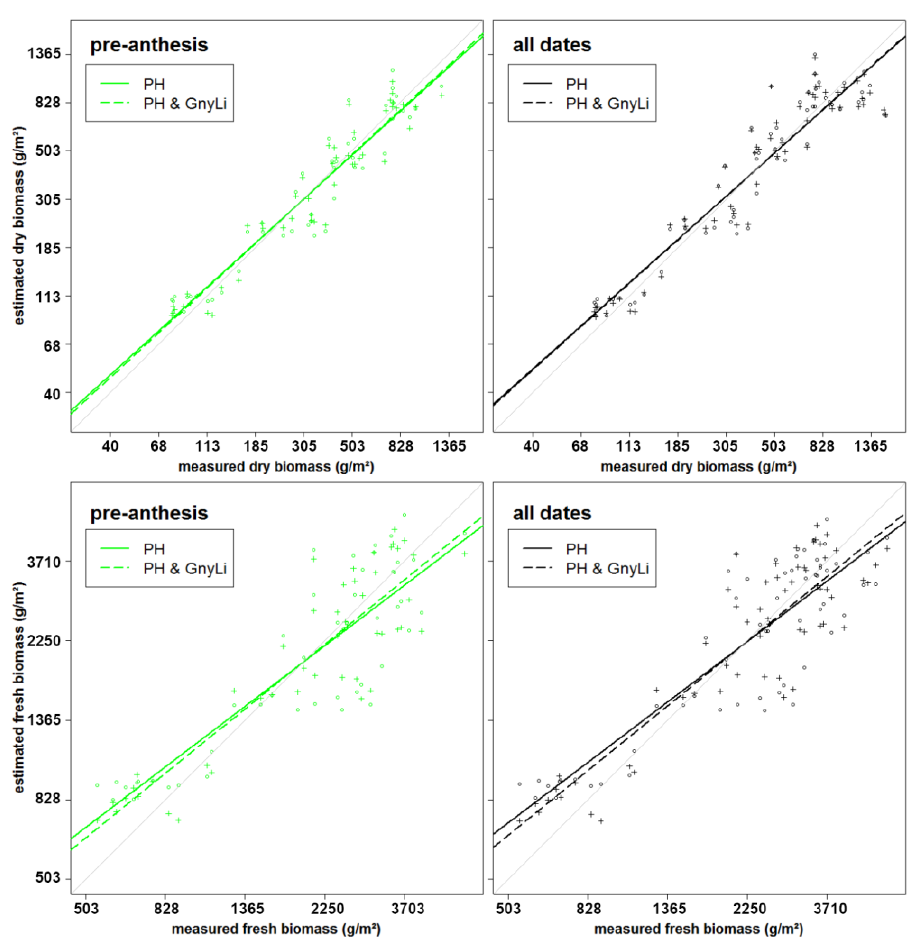
Figure 7. Scatterplot for one validation data set for the pre-anthesis (green) and for the whole observed period (black) of the bivariate BRM of PH (circles and solid regression line) and multivariate BRM of PH and GnyLi (crosses and dashed regression line) for fresh biomass (top) and dry biomass (bottom) (all exponential models); 1:1 line: light